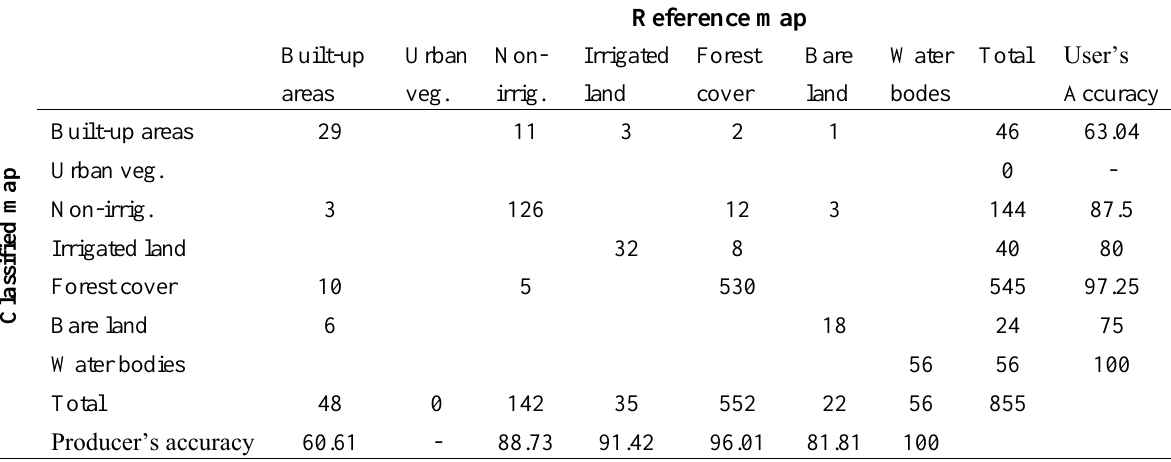
Table 4. Error matrix (%): image classification of 2000.